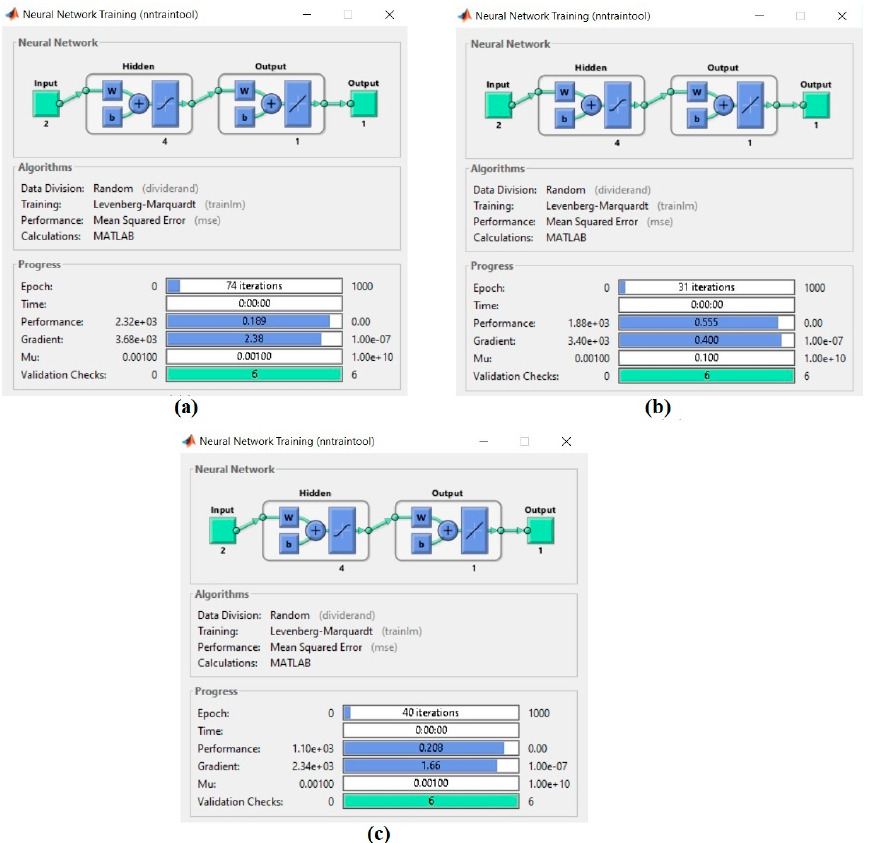
Figure 7. Artificial neural network (ANN) settings for the best model for diclofenac ( a ), ibuprofen ( b ), and naproxen ( c ).